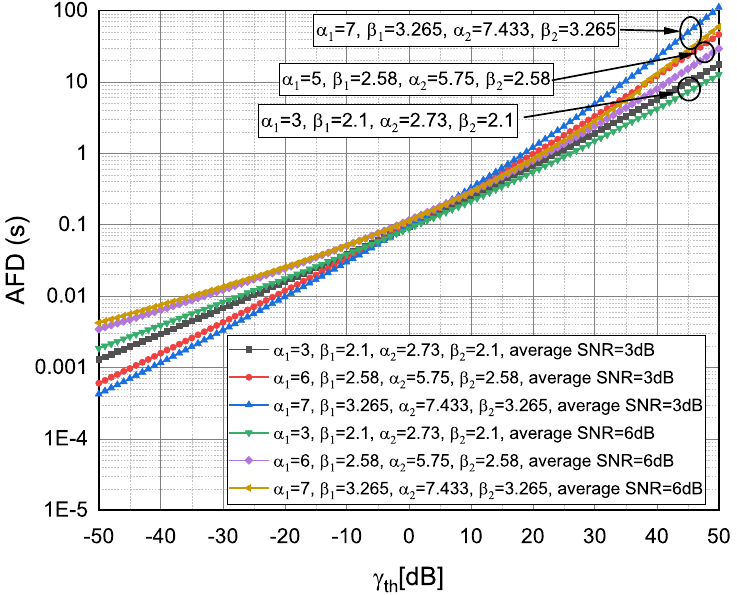
Figure 7. Average fade duration versus γ th observed for different TI fading severity conditions and different ¯ γ th